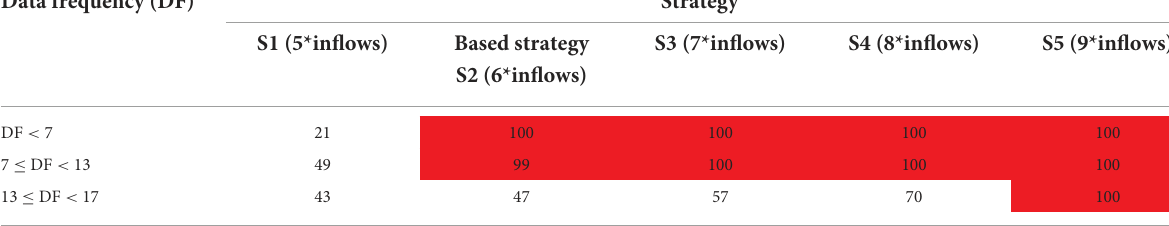
TABLE 10B Probabilities of the OPREM meeting the higher band width value given the data frequency (ratio analysis). Data frequency